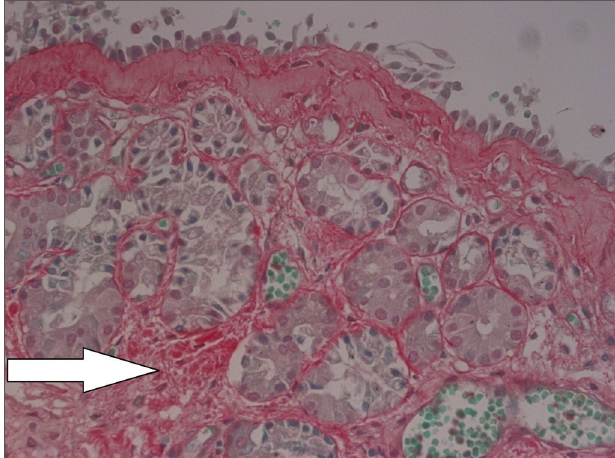
Figura 2. Discreta fibrose subepitelial na mucosa nasal de paciente com rinite alérgica não infectado pelo HTLV-1. Vermelho Sirius, 400X.